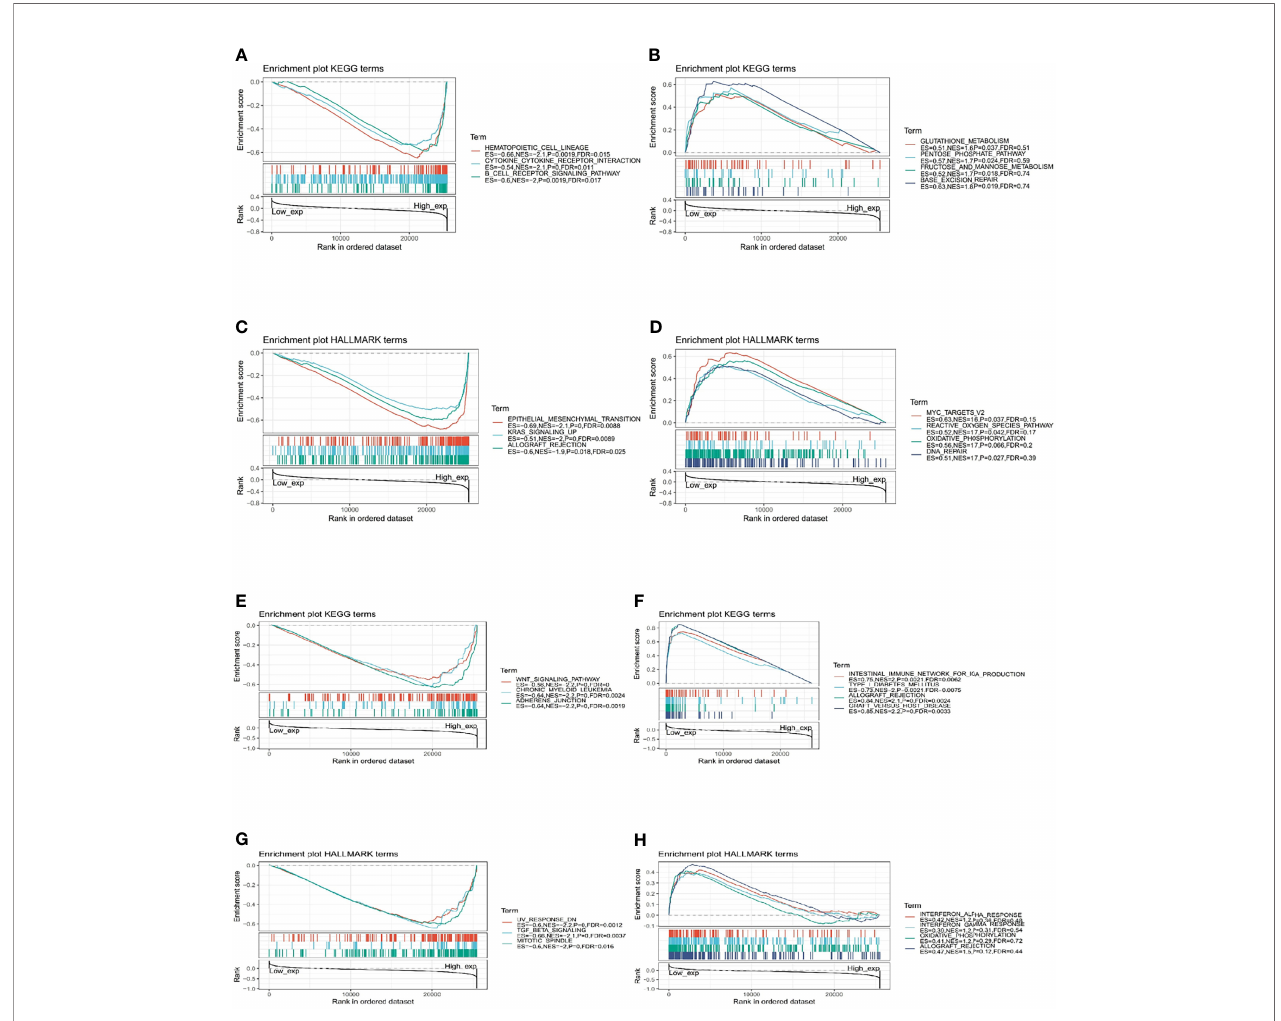
FIGURE 8 | Functional Enrichment of KEGG and HALLMARK terms on IGF-1 and IGF-1R through GSEA. The top 3 negatively and positively enriched KEGG terms on IGF-1 are displayed in (A, B) , respectively. The top 3 negatively and positively enriched KEGG terms on IGF-1 are displayed in (C, D) , respectively. The top 3 negatively and positively enriched KEGG terms on IGF-1R are displayed in (E, F) , respectively. The top 3 negatively and positively enriched KEGG terms on IGF-1R are displayed in (G, H) ,